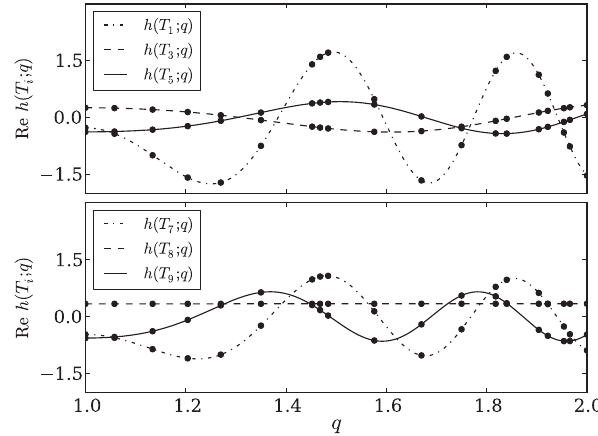
FIG. 17. The curves depict the values of the real parts of the waveforms along with the greedy data as a function of the mass ratio for our EOB example case. Only curves at a few represen- tative empirical times are shown. While there is less structure here than in the coefficients shown in Fig. 16, the majority of functions still require additional sampling to be accurately resolved by global polynomial